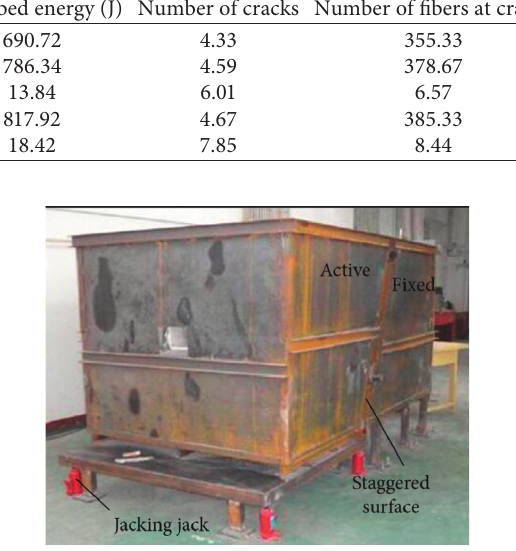
Figure 5: Leaning straight stick-slip dislocation test